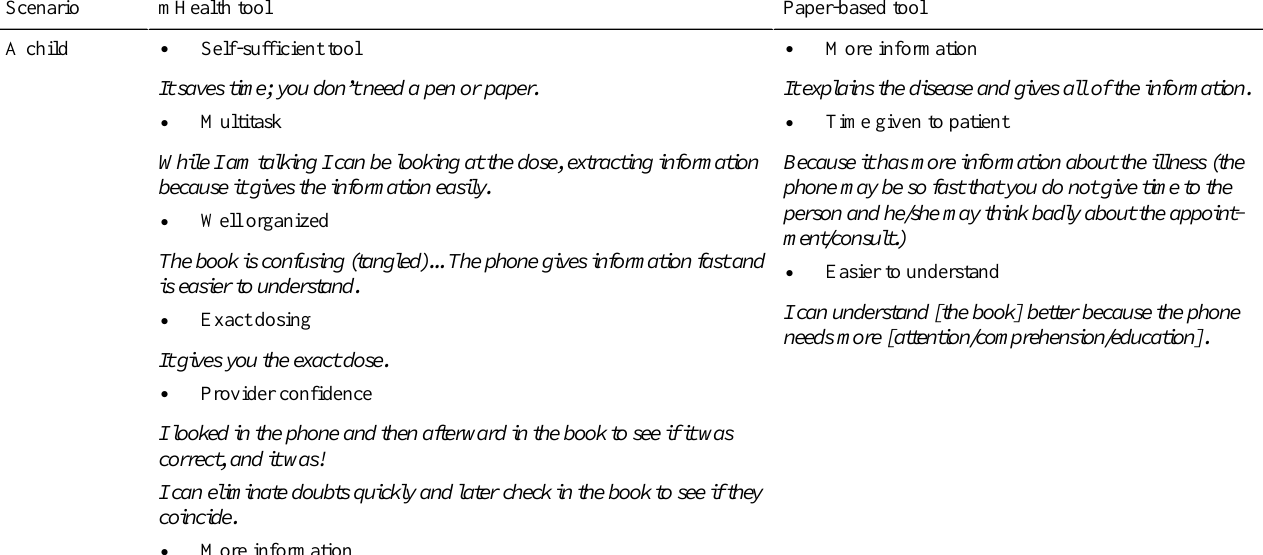
Table 4. Narrative responses about tool preference in 5 hypothetical clinical